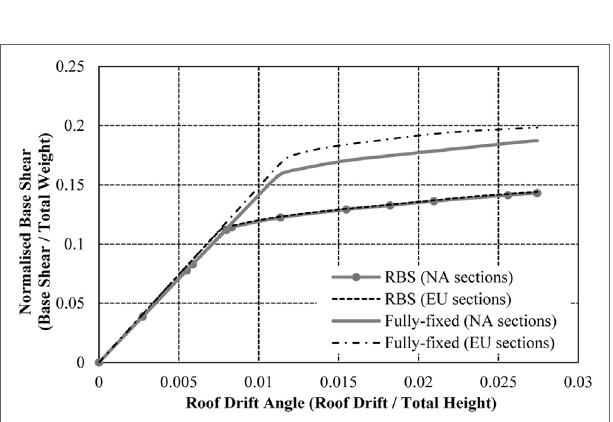
Figure 12 | NA vs EU sections normalized capacity curve comparison for 16-storey frame.